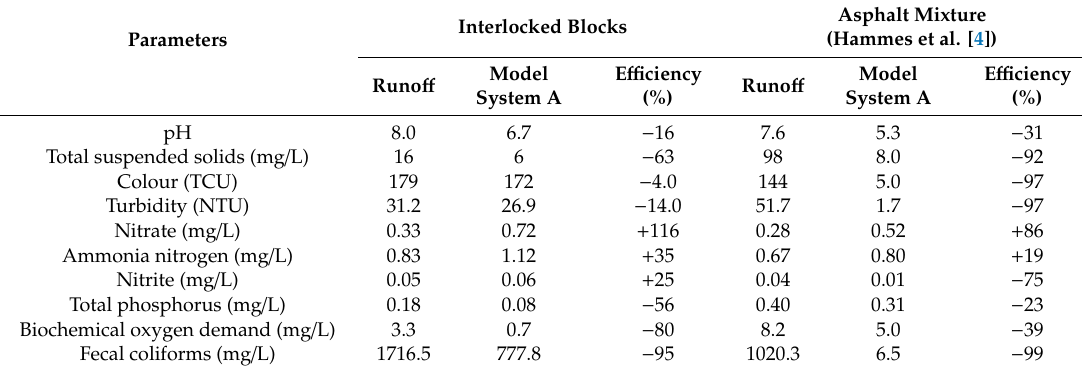
Table 6. Comparison of quality results for model system A.